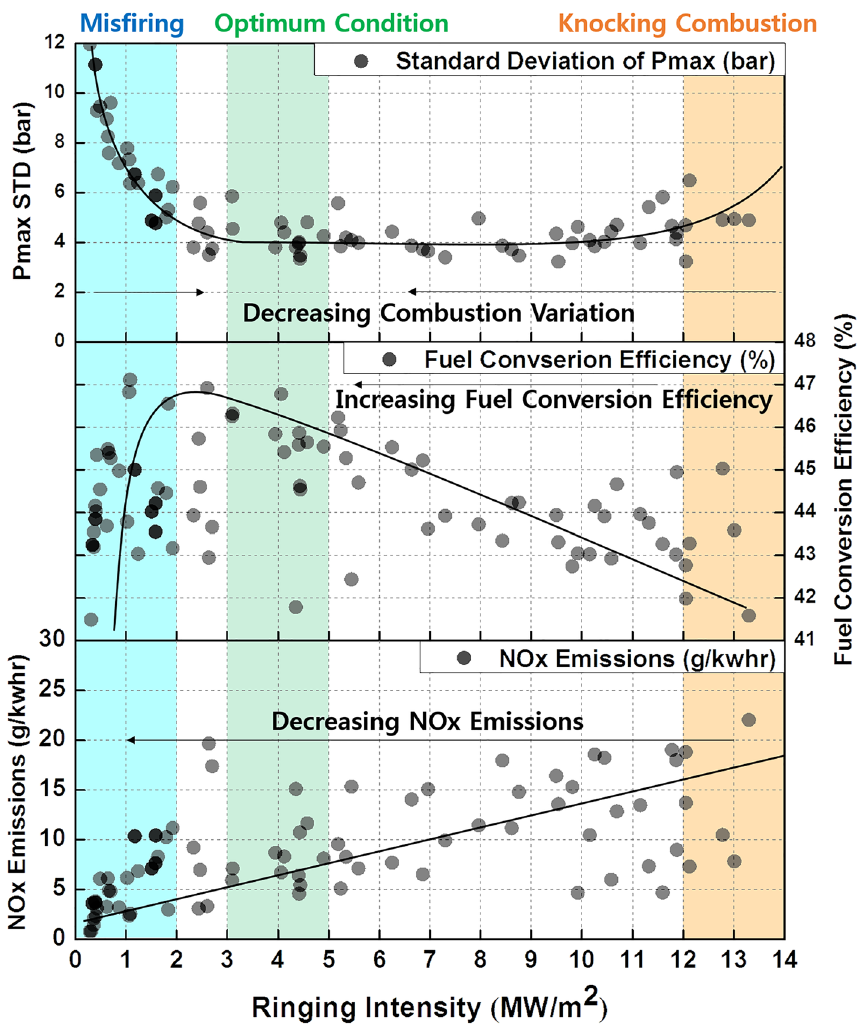
Figure 23. Distributions of the combustion variation, fuel conversion efficiency, and NOx emissions in the middle RI regime.